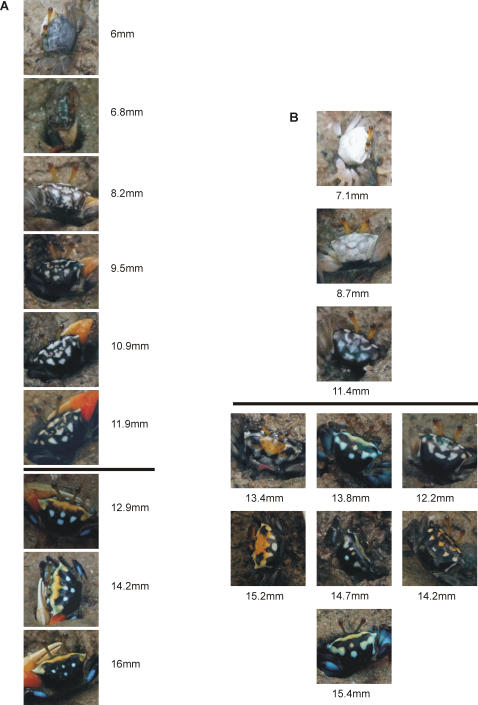
Changes in colouration associated with moulting in Uca capricornis.(a) The typical male progression from a mottled black and white pattern, to distinct white spots with a yellow scarf is illustrated by the successive moults of 2 males, separated by a line. (b) Females have a more variable progression. The successive moults of one small individual are presented to represent the less colourful phase, and three individuals are presented to illustrate the more variable colour patterns of larger females, with their corresponding carapace widths below.